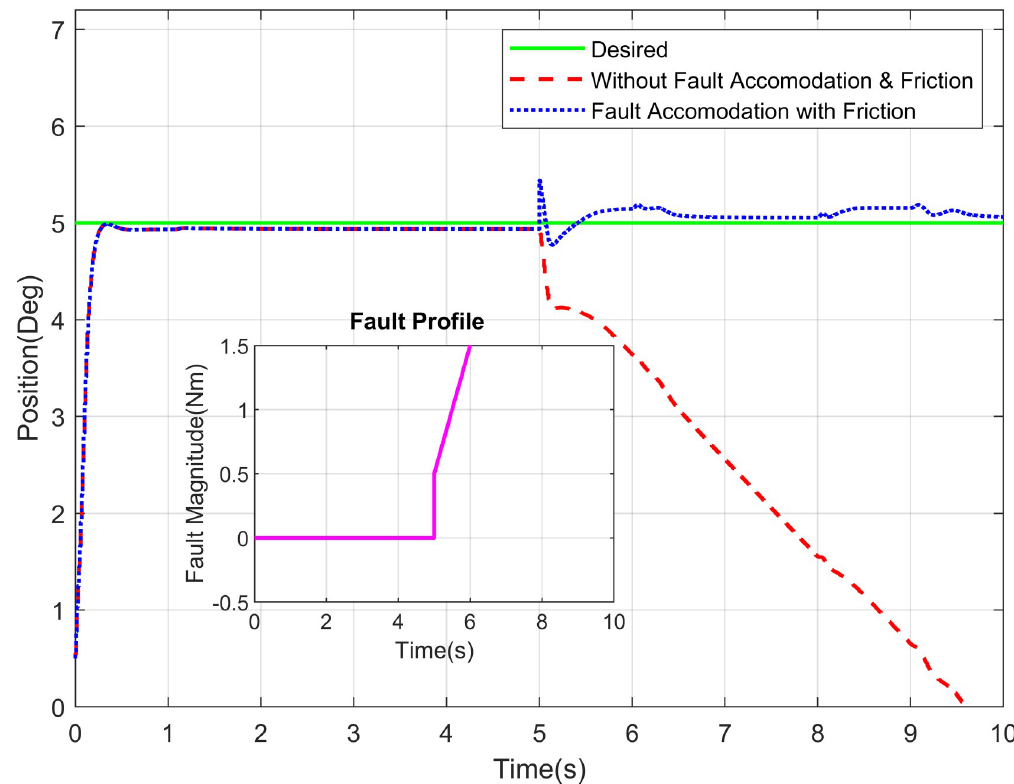
Fig 17. Position tracking of elbow joint of a robot manipulator with incipient fault